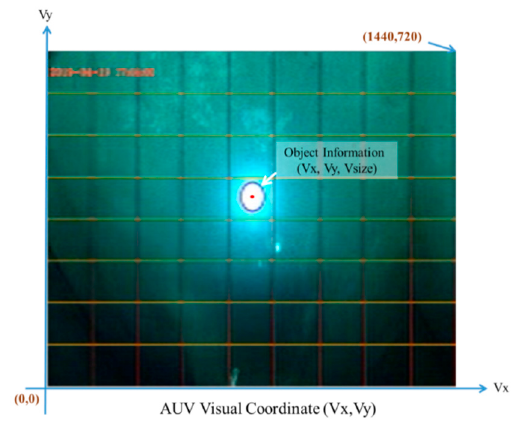
Figure 13. Object-tracking tests of Bigeye Barracuda in National Cheng Kung University’s towing tank.